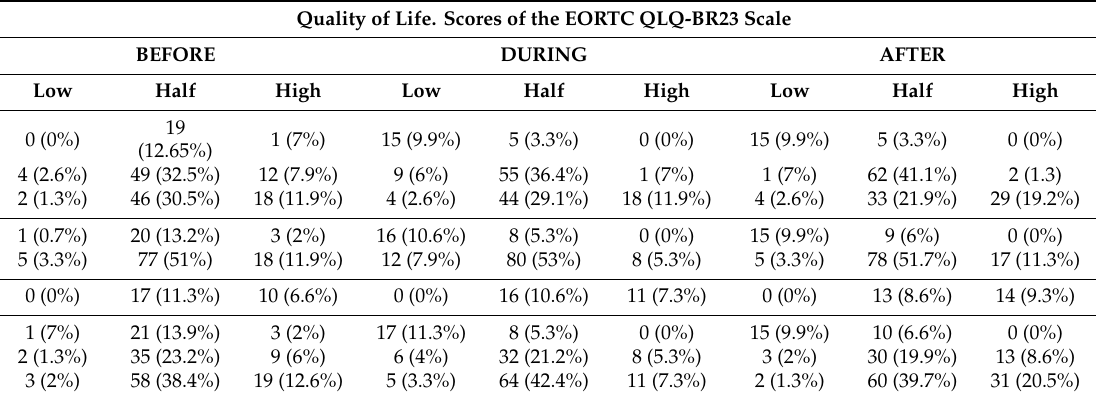
Table 4. Development of Quality of Life throughout